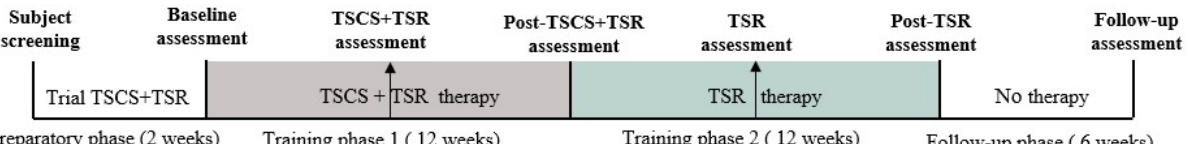
Table 1. The demographic and clinical characteristics of the participants.